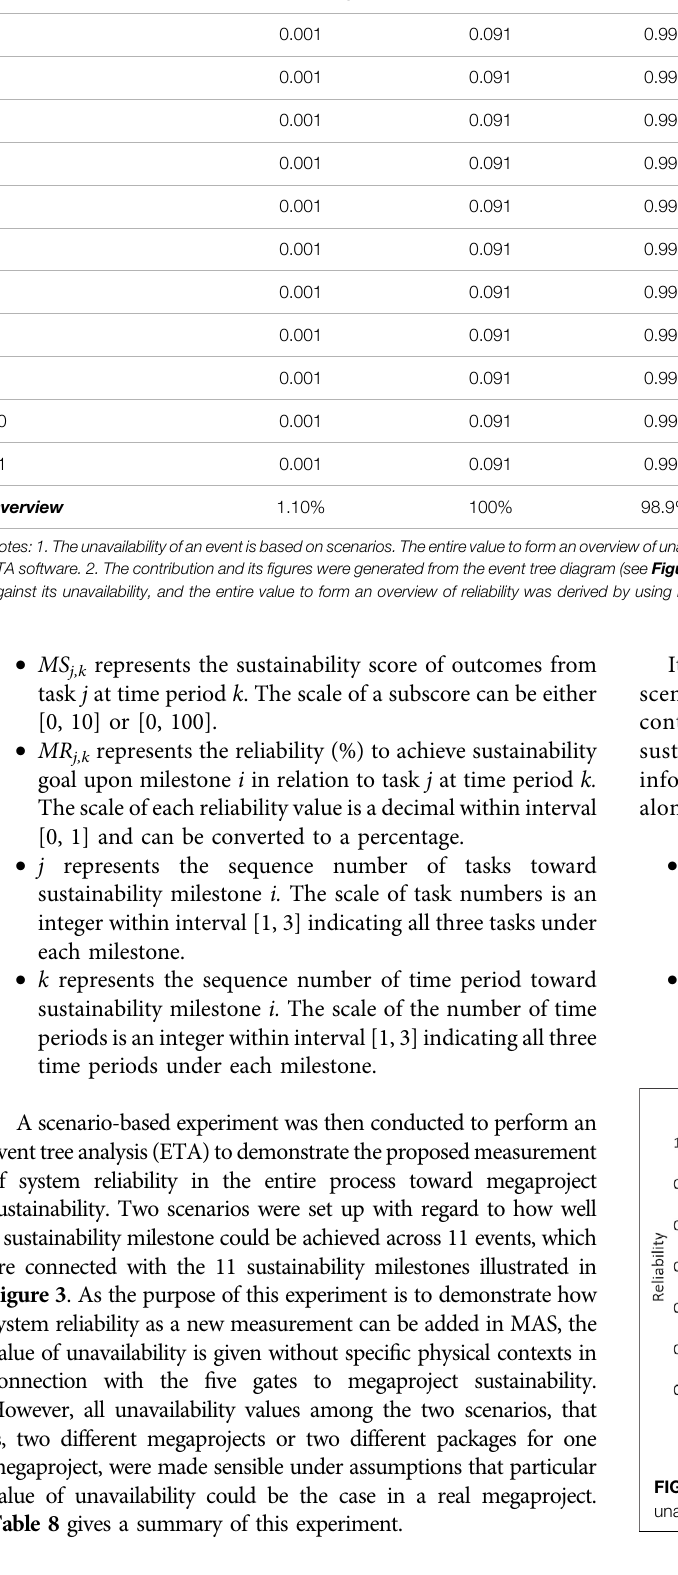
TABLE 8 | A scenario-based comparison on ETA. Events ( sustainability milestone )